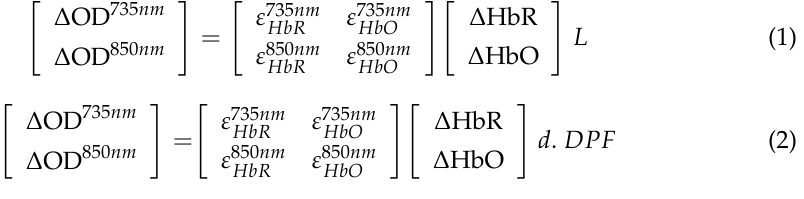
Figure 17. Light intensity sensed by PDs (six fNIRS channels) for darker and brighter silicone phantoms.